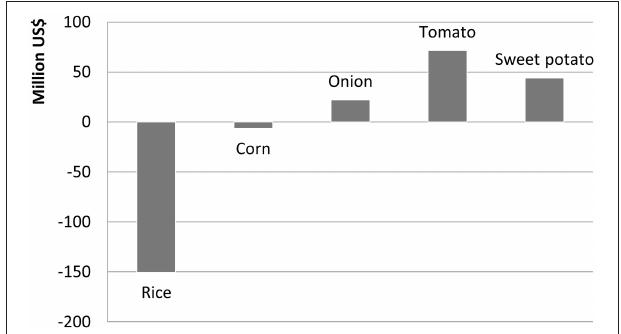
FIGURE 3 | Cumulative NPV over 20 years of the irrigation scheme in the S-SRV.